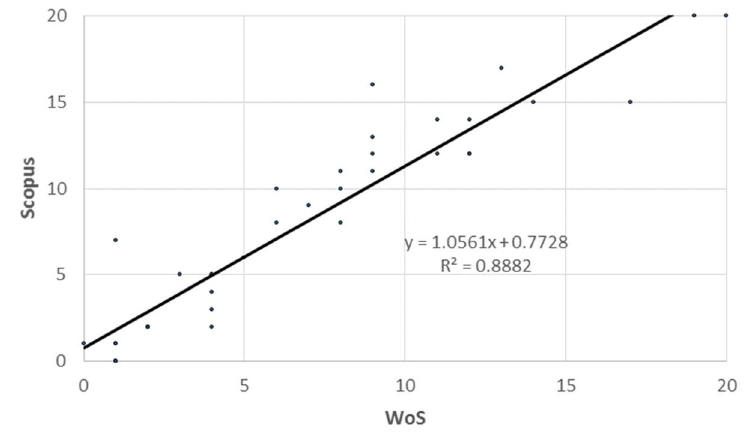
Figure 4. Correlation between the number of articles published per year in WoS and Scopus. Source: own elaboration.